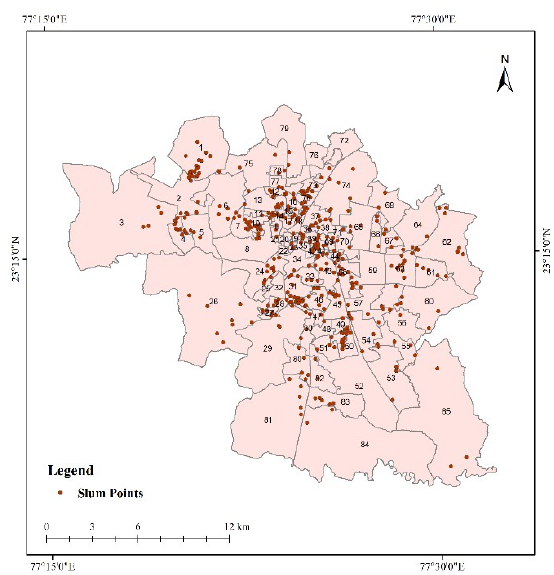
Figure 4. Distribution of